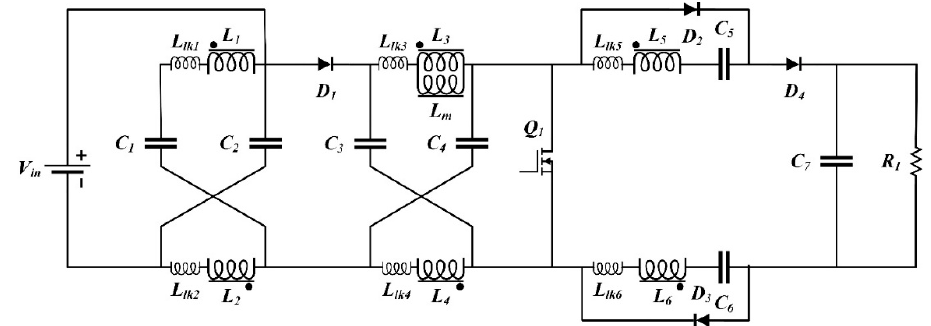
Figure 3. Circuit diagram of proposed converter with equivalent circuit of coupled inductors.